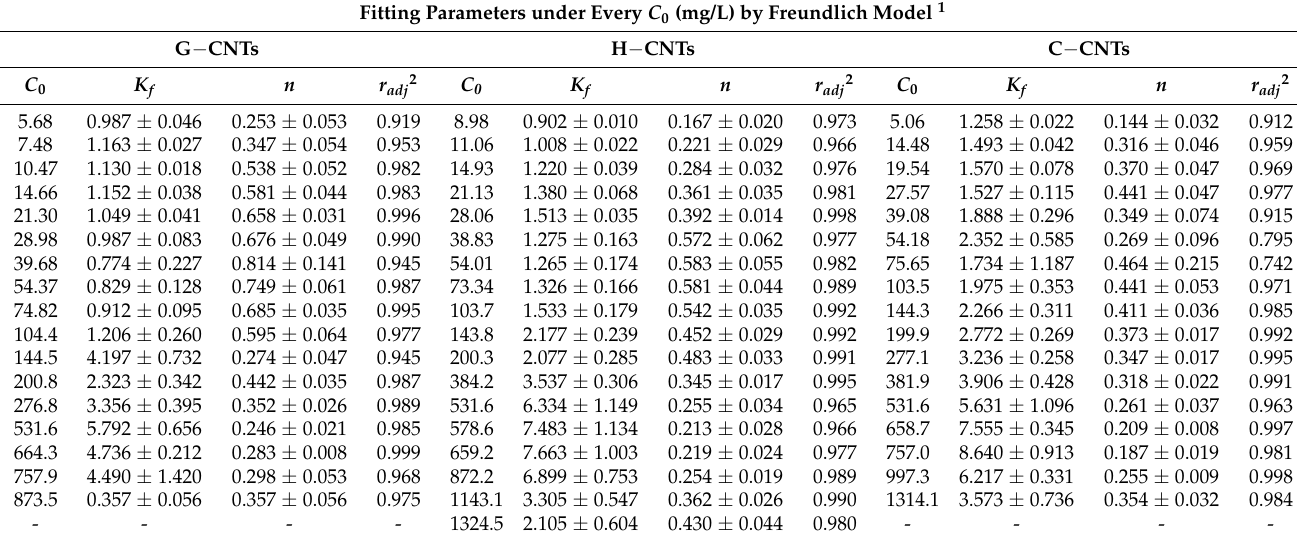
2 ) were determined by adj